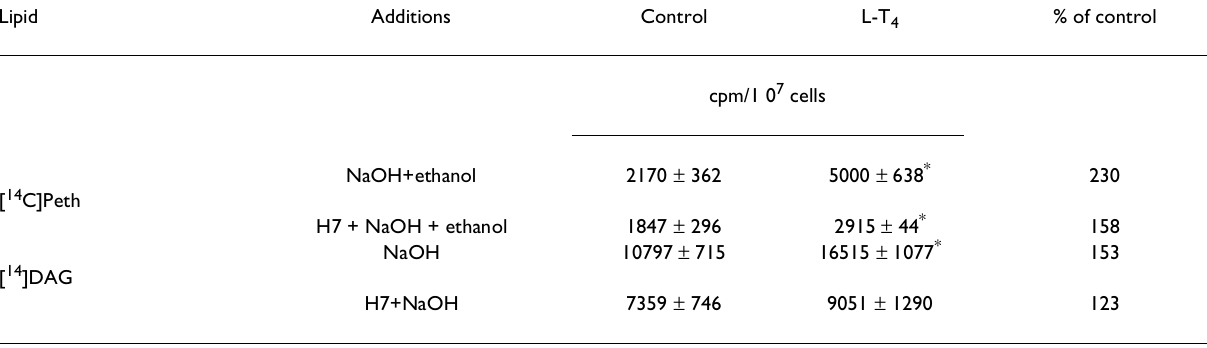
Table 2: Effect of H7 on the L-T 4 -induced DAG and Peth formation in [ 14 ]oleic acid pre-labeled hepatocytes.